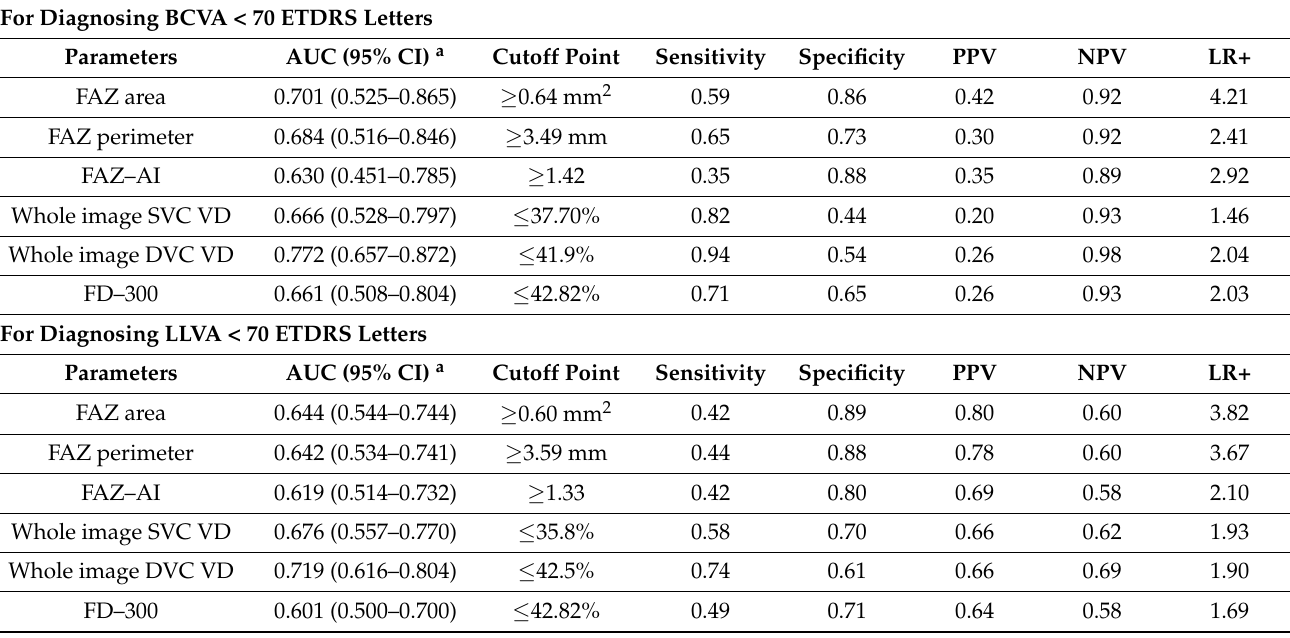
Table 3. The diagnostic values of different parameters in identifying visual